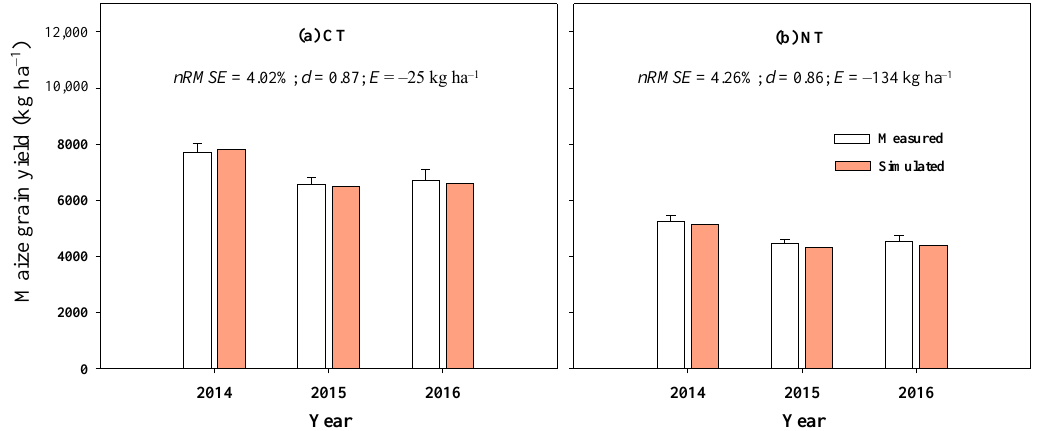
Figure 3. Measured and simulated maize grain yield for CT and NT during 2014‒2016.